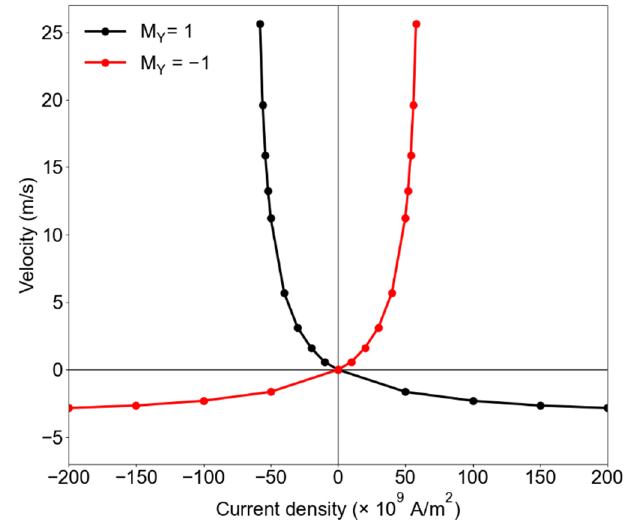
Figure 2. Velocity vs. current density for both Bloch chiralities in a 10 nm thick, 𝑀 (cid:3046) = 400 kA/m magnetic film. Saturation of negative velocities at high current densities are clearly observed, as well as the enhanced velocity in proximity to current densities required for reversal of the domain wall magnetization, nominally |𝚥⃗| = 58 × 10 (cid:2877) A/m 2 .